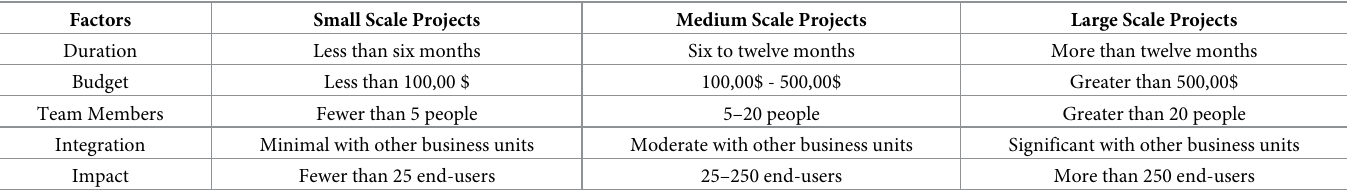
Table 5. Categorization of small medium and large scale projects.